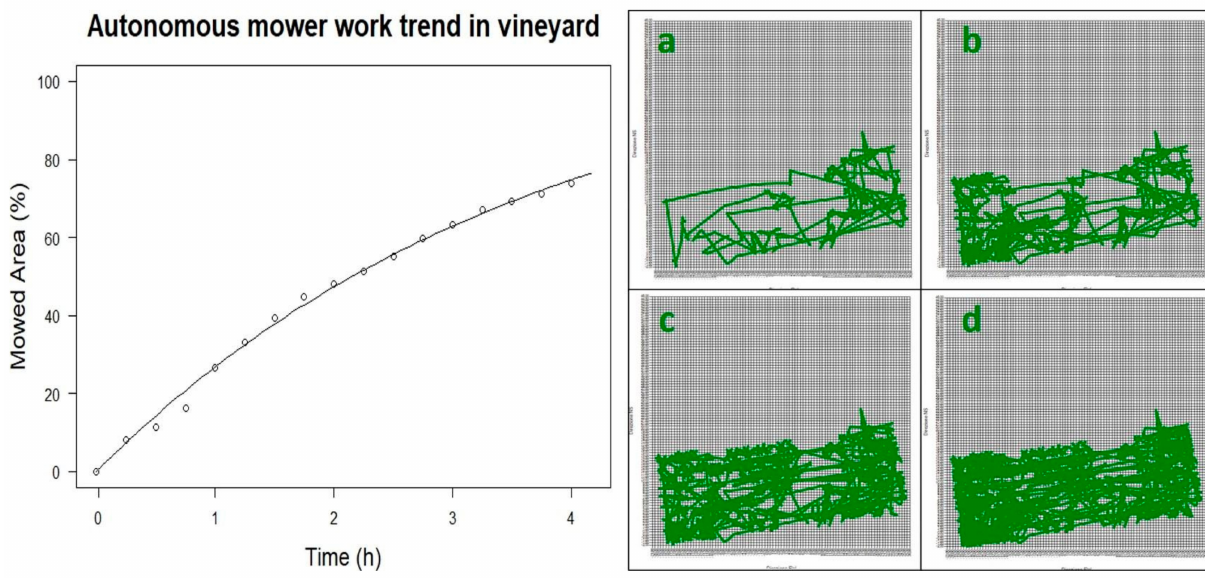
Figure 5. Left : Asymptotic regression curves with average points of the percentage of mowed area as a function of time (h). Right : Custom built software showing the working path of the autonomous mower managing vineyards on 30 June 2020. ( a ) Autonomous mower work after 60 min; ( b ) Autonomous mower work after 120 min; ( c ) Autonomous mower work after 180 min; ( d ) Autonomous mower work after 240 min.